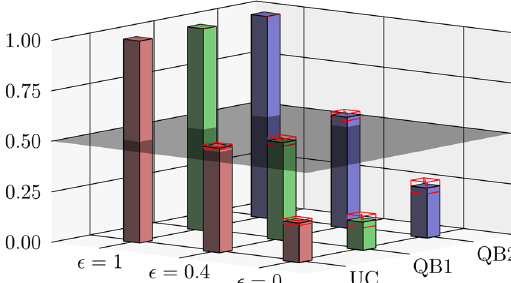
Fig. 5 Success probabilities of the cloning processes for quantum banknotes 1 and 2 (QB1 and QB2), and optimal universal cloning (UC). The red frames show the error bars of the measured probabilities. The gray surface shows the minimum cloning ef fi ciency needed to output on average more cloned photons than the input photons